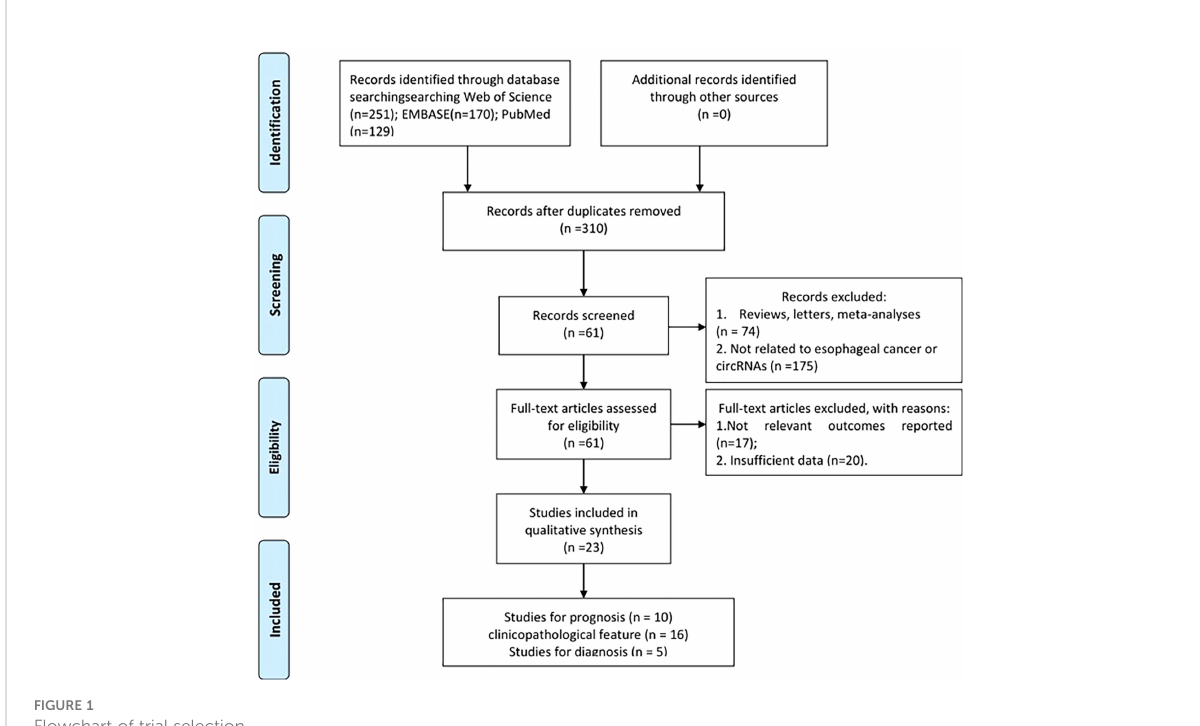
FIGURE 1 Flowchart of trial selection.